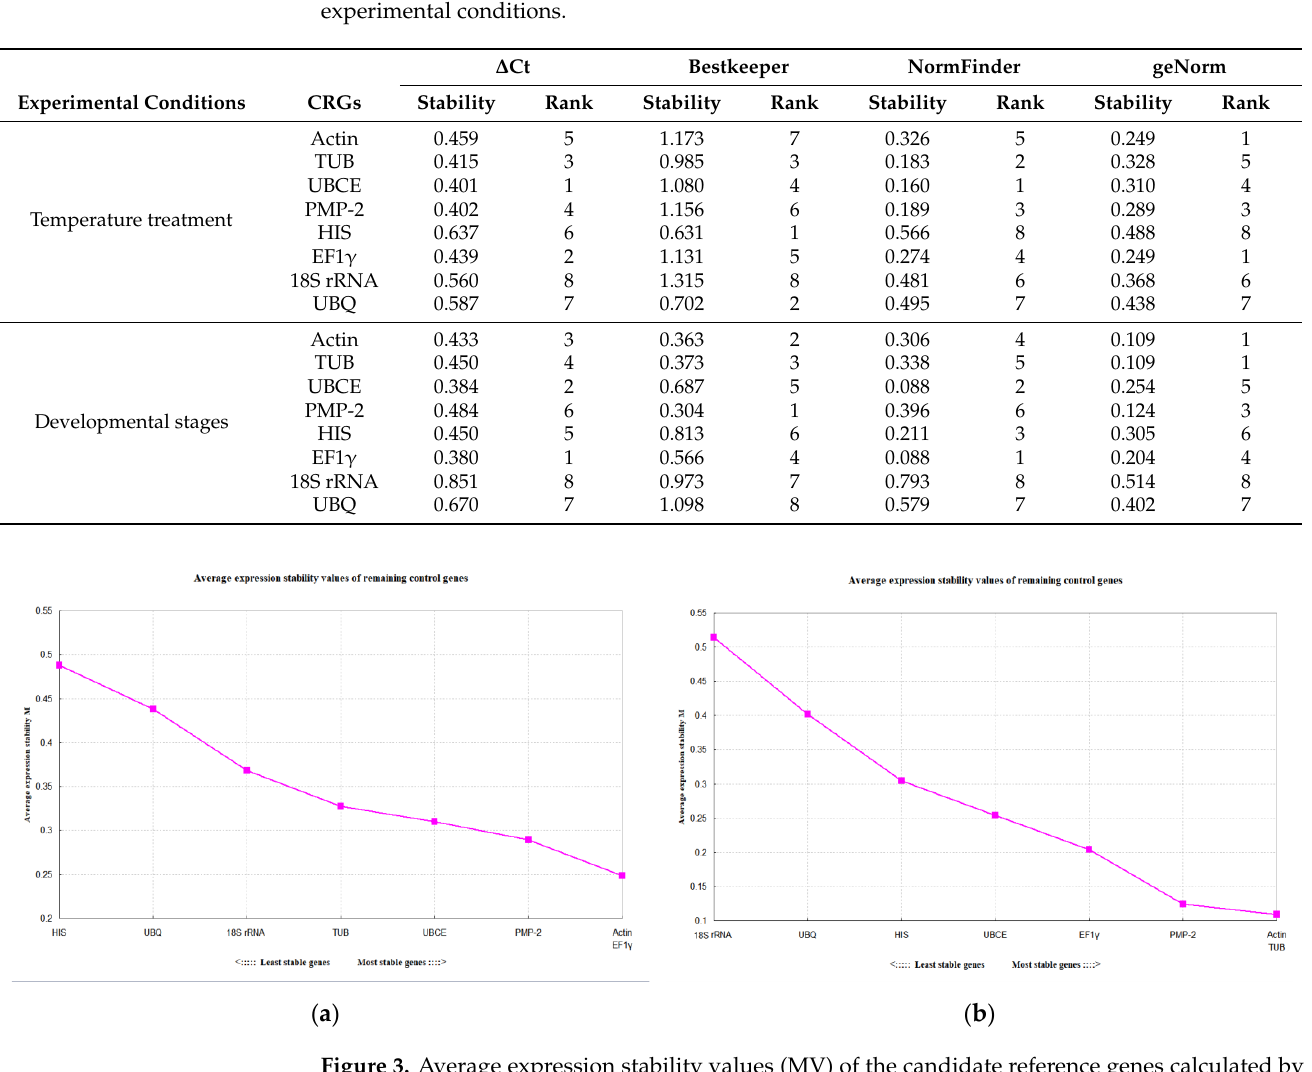
Figure 4. Expression stability of the candidate reference genes determined by RefFinder analysis. The average expression stability of the reference genes was calculated by the Geomean method of RefFinder. A lower Geomean value indicates more stable expression. ( a ) Different temperature treatments and ( b ) different developmental stages.